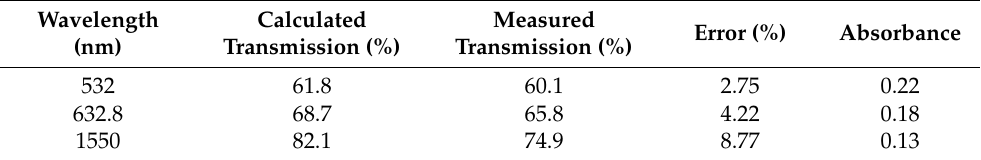
Figure 18. The dielectric constant for the PMN-PT ceramic as a function of temperature. The peak dielectric constant of 11,688.9 is reached at room temperature, approximately 25 °C.